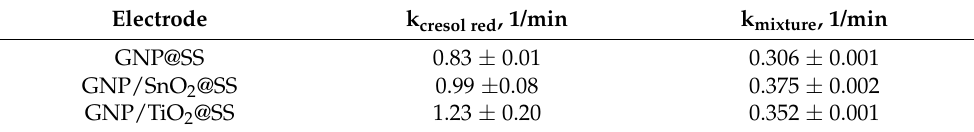
Table 2. Pseudo-first-order rate constants of degradation of cresol red and total dyes mixture. Electrode